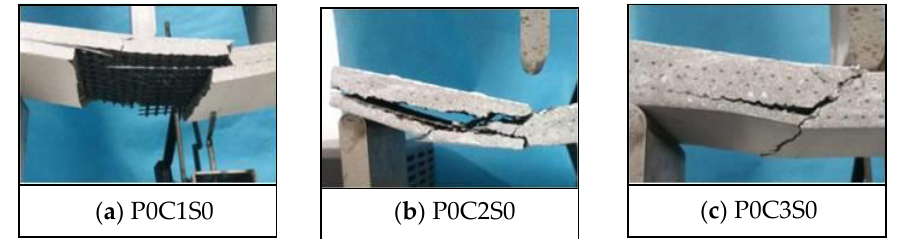
Figure 10. Crack number of the TRC specimens.